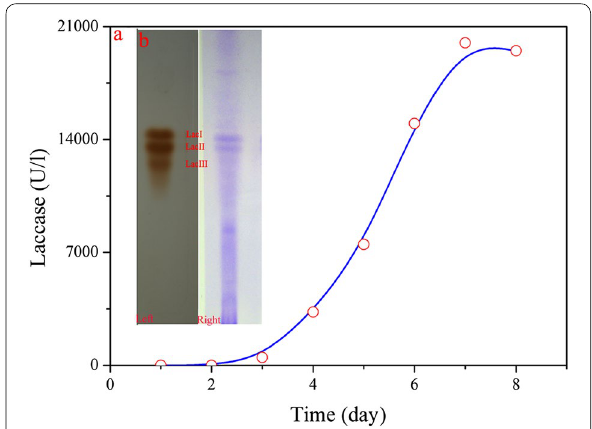
Fig. 1 Laccase activity measurement and isoenzyme analysis. a Laccase activity varied with time during the submerged fermentation; b native-PAGE analysis of laccase isoenzymes: left, guaiacol staining; right, Coomassie brilliant blue